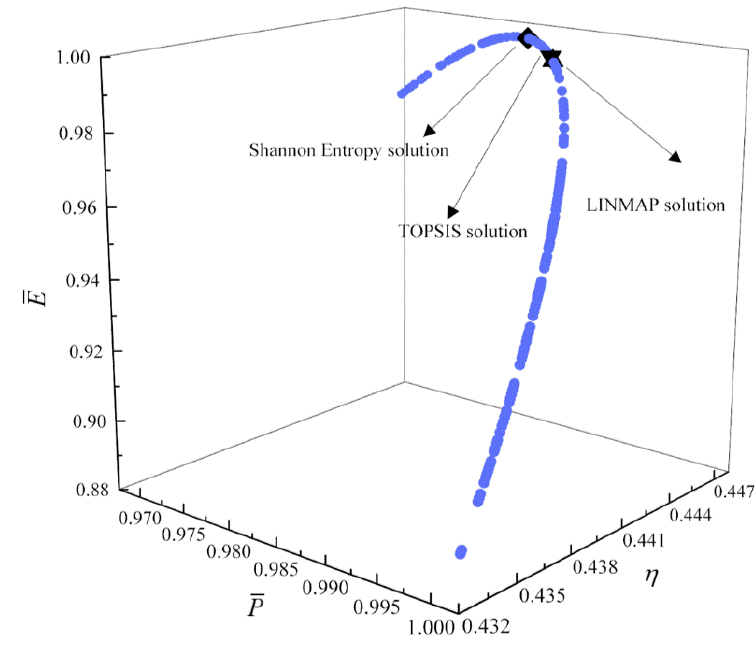
Figure 10. Quadru-objective optimization on